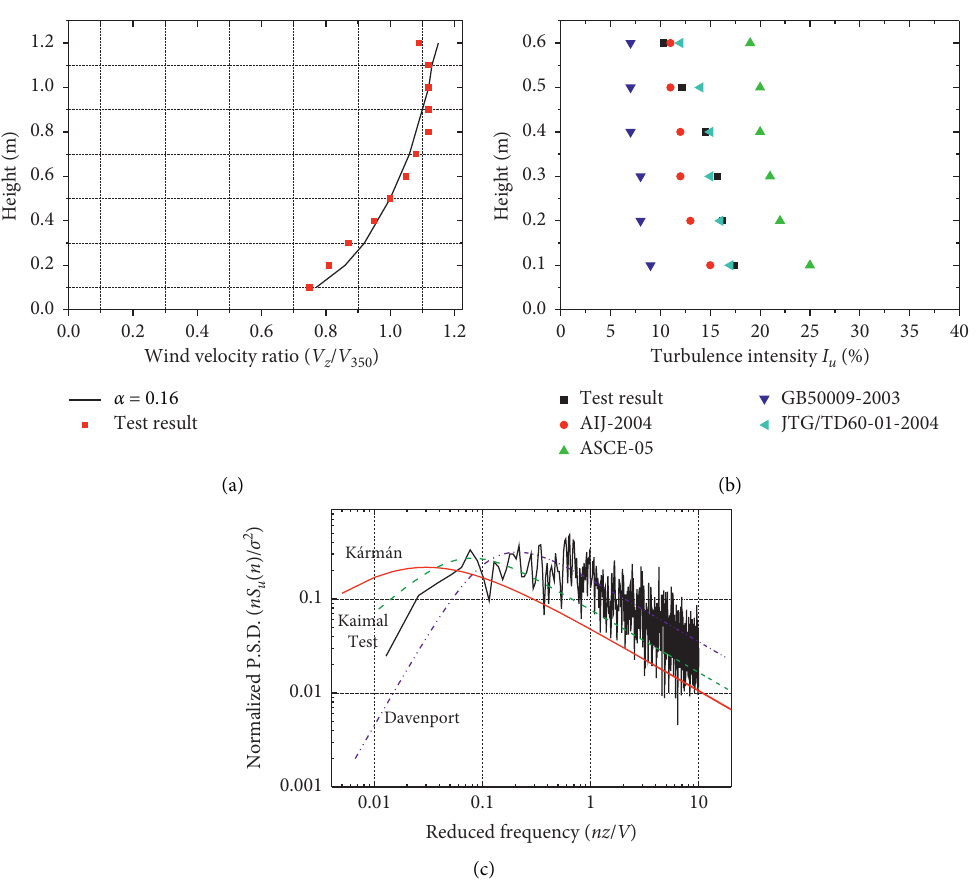
Figure 1: Simulation of wind characteristics in BLWT ( V z is the wind speed at height z , V350 is the gradient velocity, and I u is the turbulent intensity). (a) Mean wind speed. (b) Turbulence intensity. (c) Longitudinal turbulence power